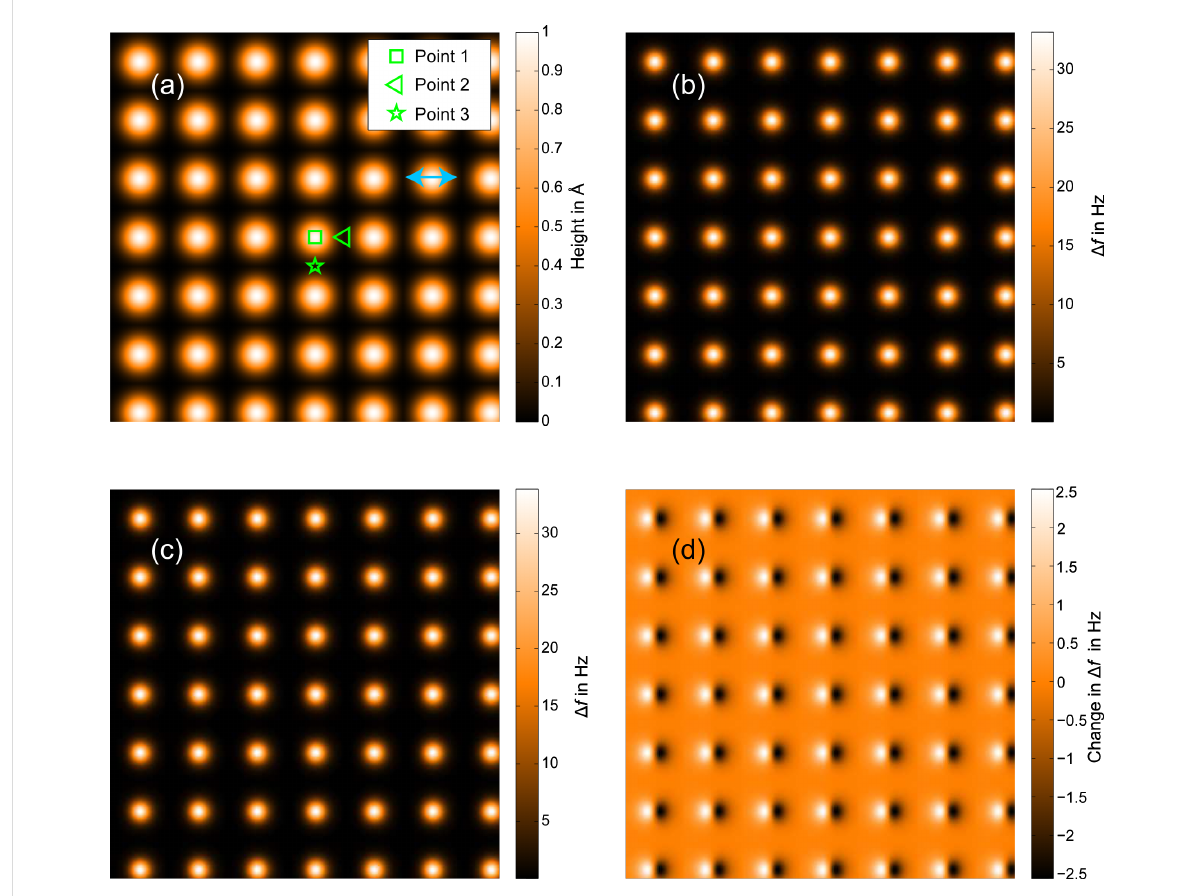
Figure 4: Effect of tip motion on imaging for an oscillation amplitude of a z = 5 Å. All image widths are 2 nm × 2 nm. (a) shows the model surface. (b) and (c) show theoretical Δ f images for constant height scans with tip motion normal and at 45° to the sample surface, respectively. Lateral motion of the tip in (c) is aligned with the x axis of the scan, as indicated by the light blue arrow in (a). (d) is the difference between scans (b) and